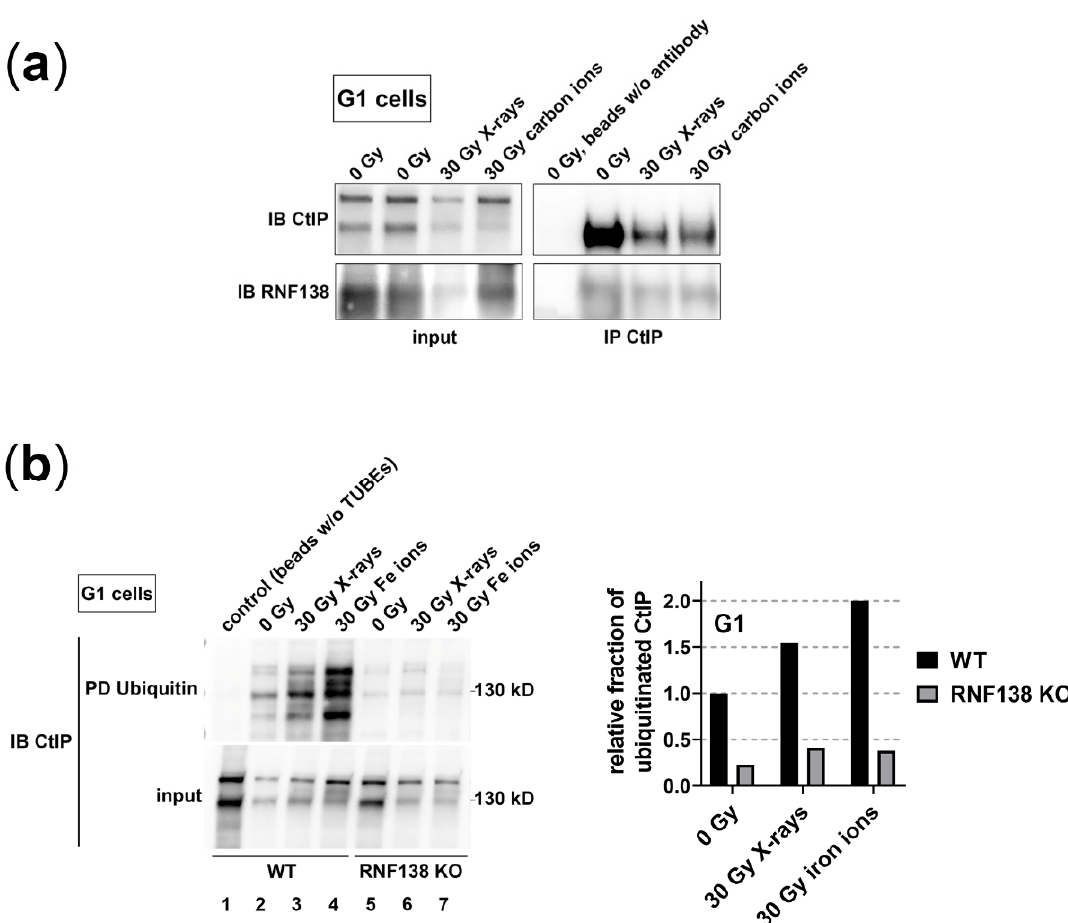
Figure 5. RNF138 is required for CtIP’s ubiquitination in G1-phase cells. ( a ) HeLa.S-Fucci cells were irradiated either with 30 Gy X-rays or 30 Gy carbon ions (6.5 MeV/nucleon). 1 h after irradiation, G1 cells were isolated via flow cytometry. For each condition, proteins were isolated from 10 6 G1 cells and CtIP immunoprecipitated. A western-blot analysis revealed that CtIP was successfully precipitated (IP) from the extracts (input) and that RNF138 was co-immunoprecipitated. IB: immunoblot ( b ) HeLa.S-Fucci cells proficient (wt) or deficient for RNF138 (RNF138 KO) were irradiated either with 30 Gy X-rays or 30 Gy high-energy iron ions. 1 h after irradiation G1 cells were isolated via flow cytometry and ubiquitinated proteins pulled down with TUBE from whole-cell extracts (“input”) (left). CtIP was detected in a pull down (PD) of ubiquitinated proteins by means of western-blot analysis. A PD reaction with cell extract of non-irradiated cells and magnetic beads without TUBE2 attached served as a PD control (lane 1). The signals of ubiquitinated proteins were quantified with ImageJ (right). IB: immunoblot. 3.6. Removal of Ku80 in the Context of DSB Resection Does Not Require RNF138 in G1-Phase Cells In G2 cells prior to HR, RNF138 promotes resection not only via the regulation of CtIP’s DSB recruitment, but also via the removal of the resection antagonist Ku80 from DSB sites [49]. In order to find out whether resection of complex DSBs in G1-phase cells is facilitated by RNF138-dependent Ku80 removal, we studied the presence of Ku80 at heavy-ion-induced DSBs 15 min and 1 h after irradiation in dependence of RNF138 (Fig- ure 6). 15 min after angular irradiation with carbon or iron ions we detected Ku80 at DSBs